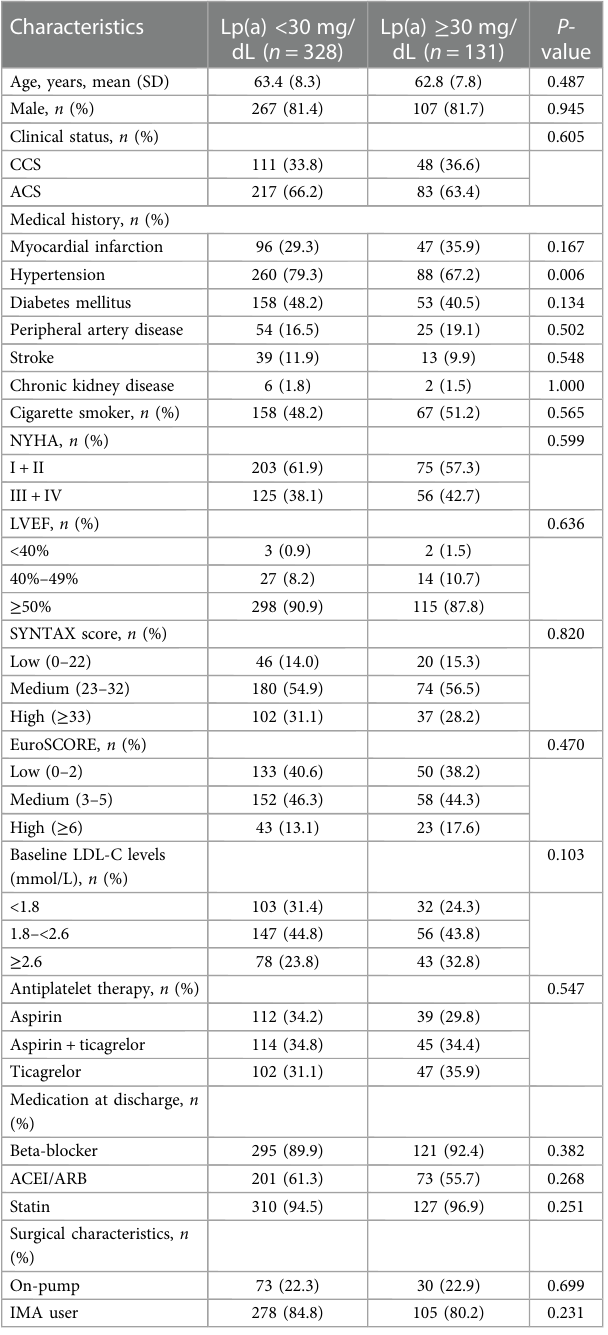
TABLE 2 Baseline characteristics of the study population strati fi ed by baseline Lp(a) levels.